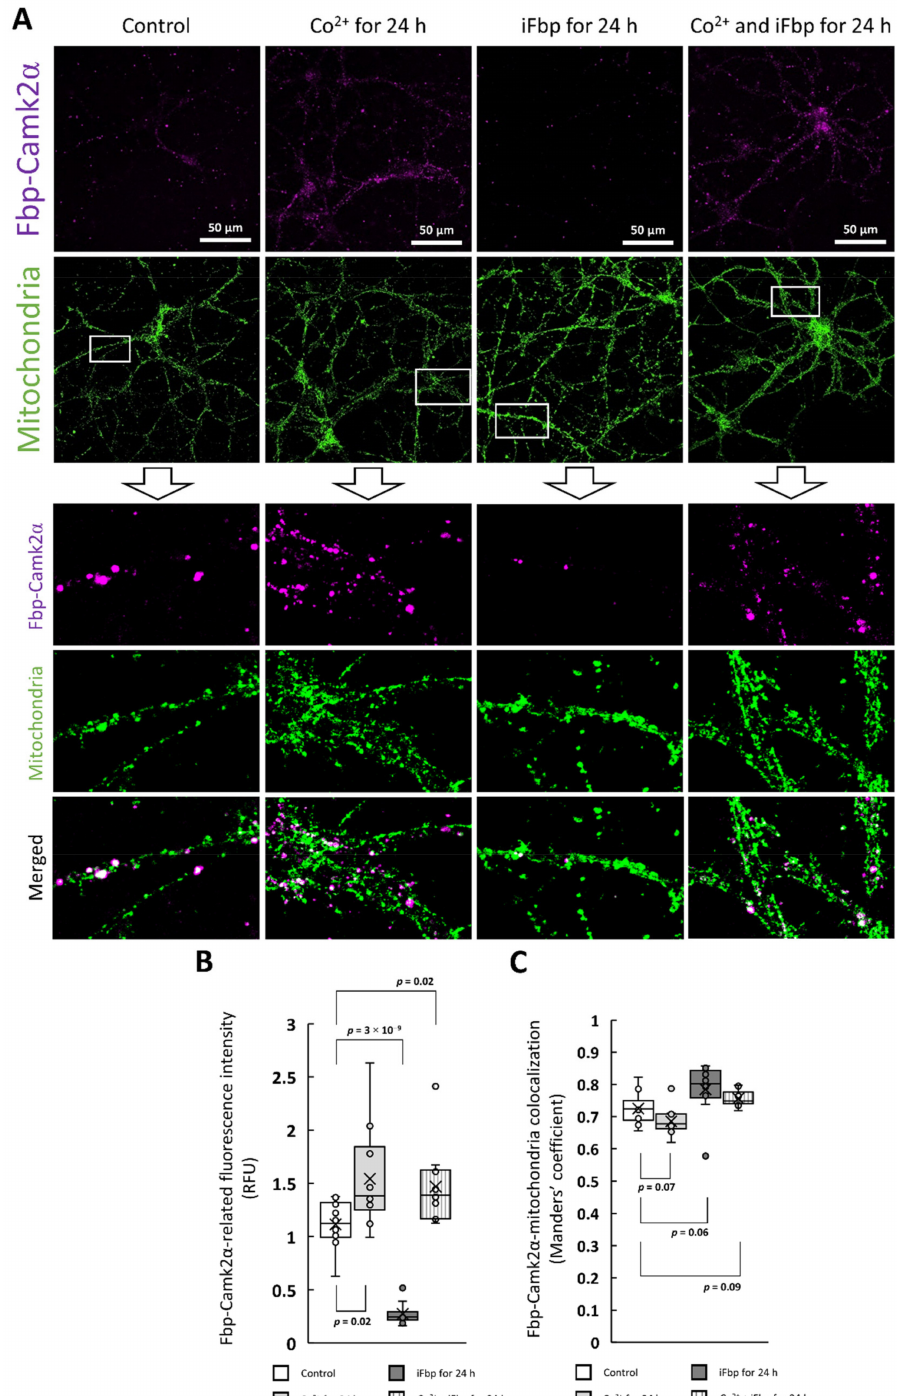
Figure 6. The Fbp-Camk2 α complex formation occurs on mitochondria. ( A , B ) The effect of Co 2+ and iFbp on Fbp2-Camk2 α complex formation in the context of mitochondrial localization. Co 2+ significantly increased the complex-related signal while iFbp decreases it. ( C ) The complex is almost exclusively localized to mitochondria. The finding that the Camk2 α forms the complex with mitochondria-bound Fbp2 indicates that an appropriate quaternary structure of Fbp2 is required to associate with Camk2 α . In other words, only the active/partially active Fbp2 (the dimeric, R-state with mitochondria and hence, may form the complex with Camk2 α